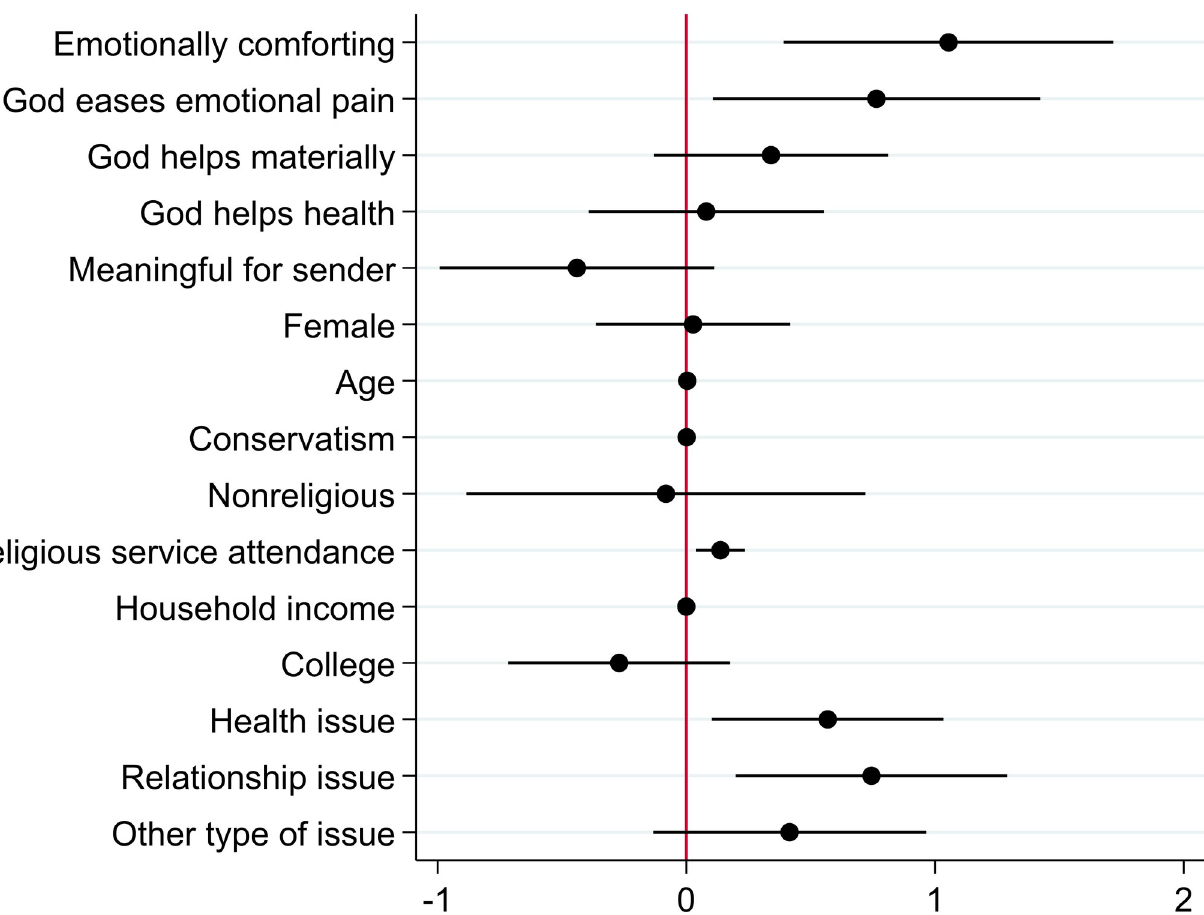
Fig 3. Determinants of the positive value of prayers. Note: Coefficients generated by Ordinary Least Squares regression, N = 406, R 2 = 0.241. Error bars represent 95% confidence intervals. A value of zero implies that the variable does not affect the average value of the positive WTP for a prayer.